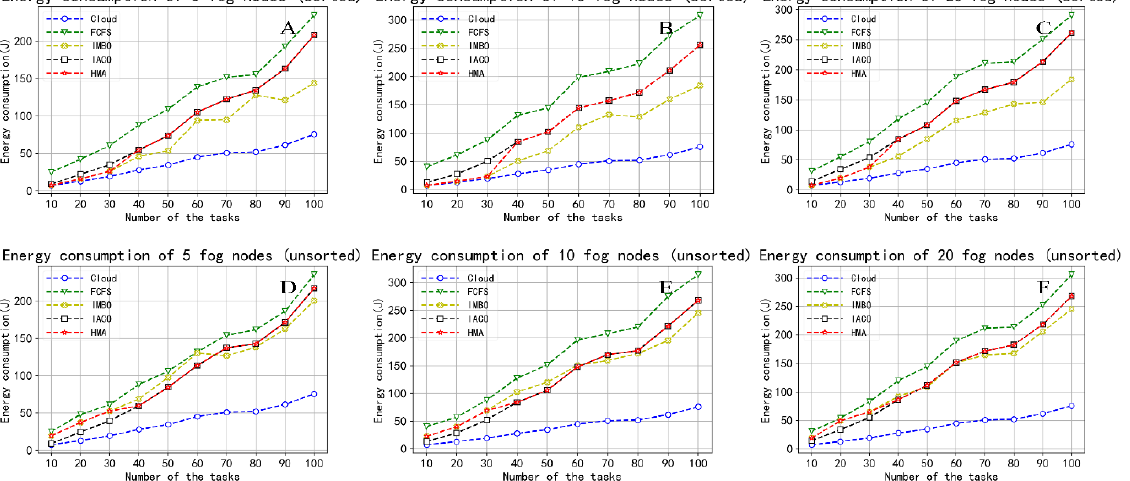
Figure 7. Comparison of the energy consumption. ( A ) Energy consumption of 5 fog nodes (sorted); ( B ) Energy consumption of 10 fog nodes (sorted); ( C ) Energy consumption of 20 fog nodes (sorted); ( D ) Energy consumption of 5 fog nodes (unsorted); ( E ) Energy consumption of 10 fog nodes (unsorted); ( F ) Energy consumption of 20 fog nodes (unsorted).